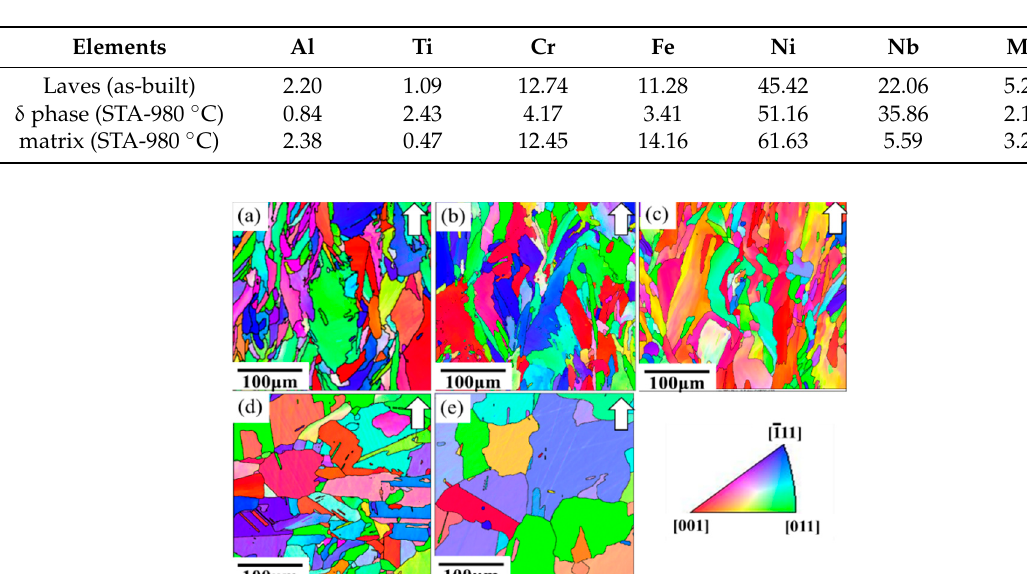
Figure 6. KAM maps of ( a ) as-built, ( b ) STA-1045 °C, ( c ) STA-1065 °C, ( d ) STA-1120 °C, and ( e ) STA- 1180 °C/1 h specimens were analyzed using the orientation measurements by EBSD. A square scanning grid and neighbor shell (5 × 5) were used to calculate the misorientation. These KAM maps were run at a 0.5 μ m step size using a 600 × 600 point grid.